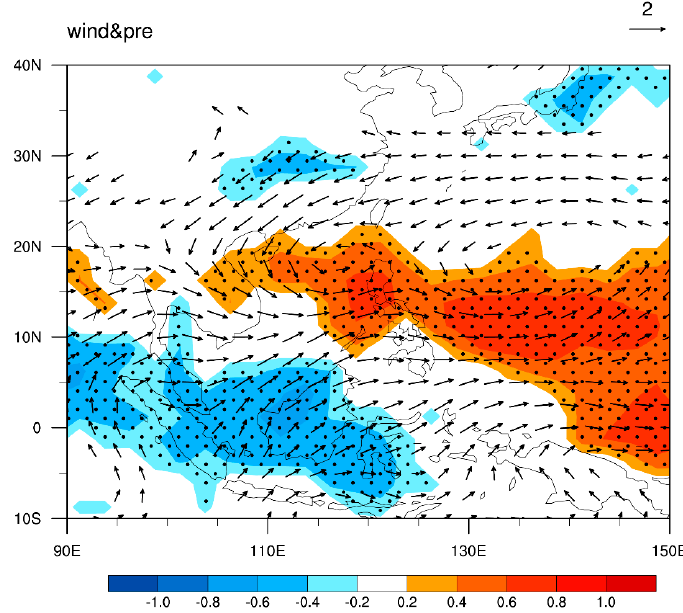
Figure 1. Correlations of summer (June–September (JJAS)) precipitation (shaded) and wind vectors at 850 hPa (vector) with the concurrent South China Sea summer monsoon (SCSSM) index (SCSSMI). Positive (red) and negative (blue) precipitation anomalies, with correlation significant at the 90% confidence level, are stippled. Only wind vectors at 850 hPa with correlation significant at the 90% confidence level are shown.